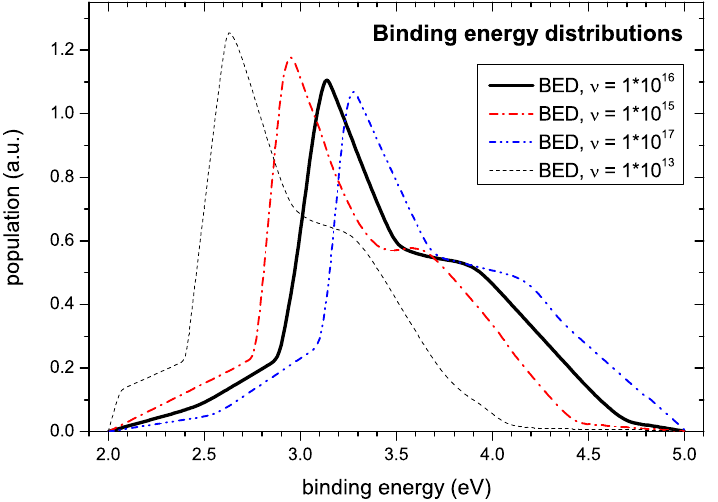
Figure 11. Comparison of different simulated binding energy distributions (population densities) calculated using ν = 1 × 10 15 1/s, ν = 1 × 10 16 1/s, and ν = 1 × 10 17 1/s. For comparison a BED using ν = 1 × 10 13 1/s is also